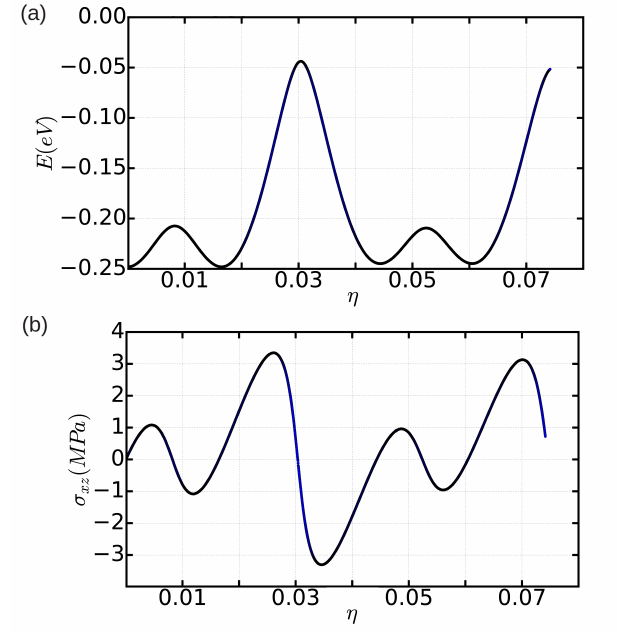
Figure 9. Energy ( a ) and shear stress ( b ) expressed as a function of shear strain for a simulation cell containing n = 18,424 atoms in which periodic boundary conditions are applied along the three Cartesian